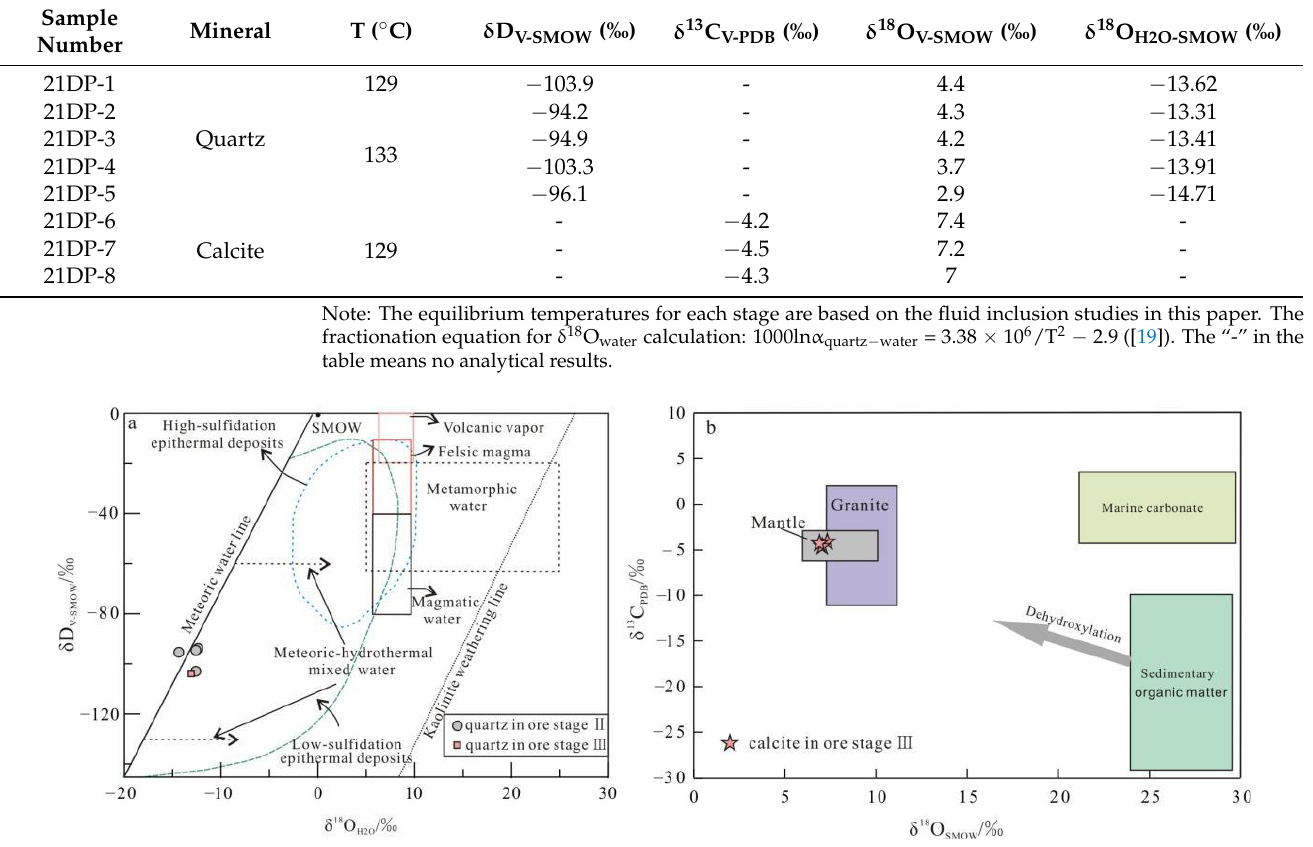
Figure 7. Diagrams of δD—δ 18 O ( a ) and δC—δ 18 O ( b ) (( a ) is modified from [20,21]; the fields for the epithermal deposits and meteoric-hydrothermal mixed water are from [22] and [23], respectively; ( b ): the carbonate fields of marine carbonate, sedimentary organic carbon, and magma-mantle carbonate are from [24] and [25], respectively).